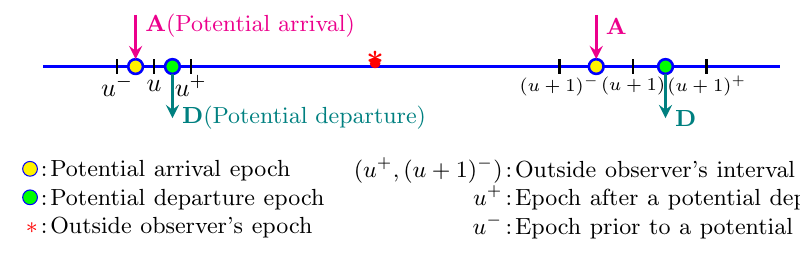
Figure 1. Various time epochs in